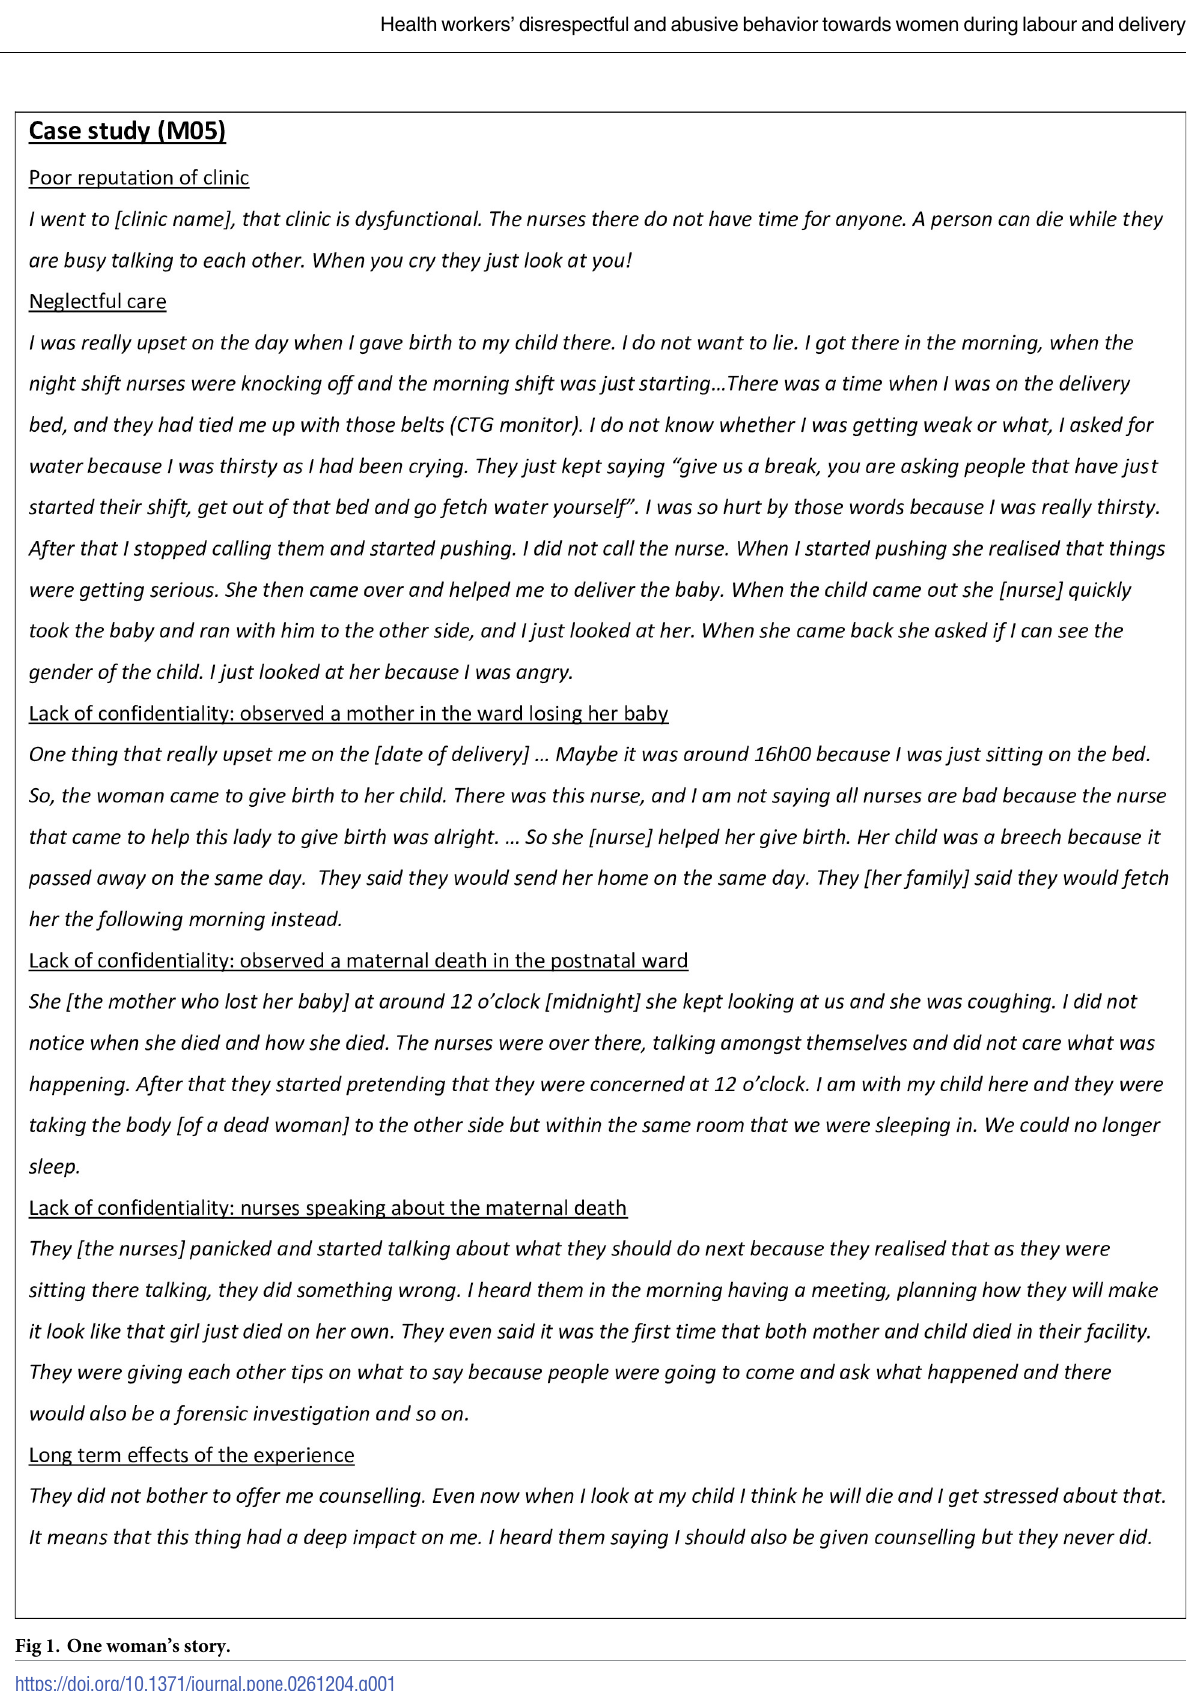
Fig 1. One woman’s